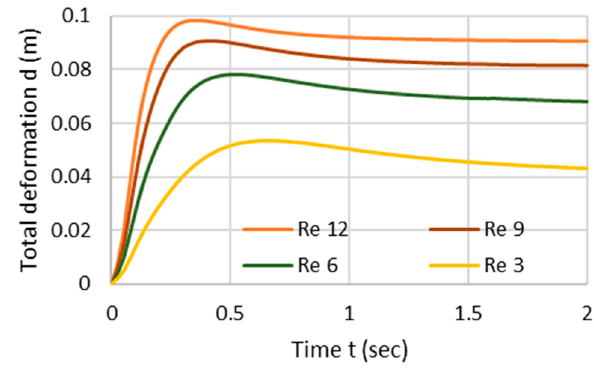
Figure 7. Deformation verses time as a function of Reynolds number.